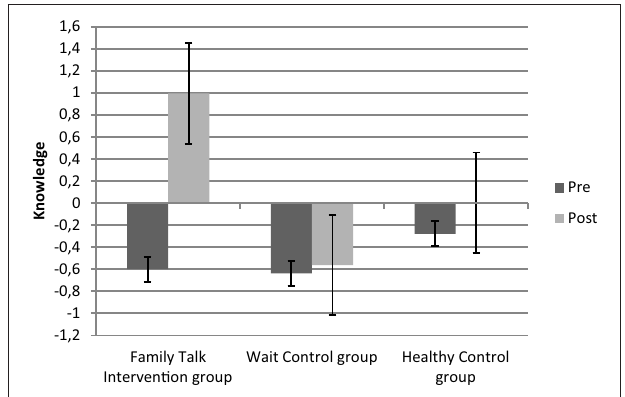
FIGURE 1 | Z-standardized knowledge-scores before (pre) and after (post) the intervention for the three different groups.